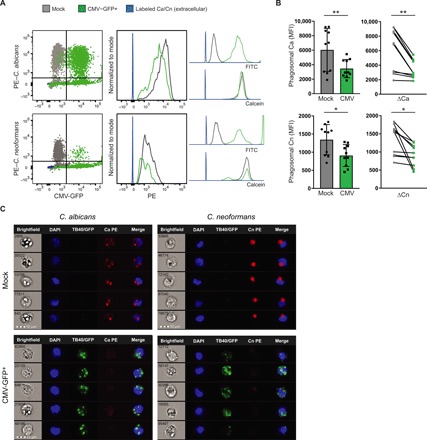
CMV-infected monocytes have a decreased phagocytic index for C. albicans and C. neoformans.pHrodo-red–labeled C. albicans (Ca) and C. neoformans (Cn) were incubated with mock- and CMV-infected PBMC cultures at a ratio of 5:1 for 1 hour, and phagocytosis of these fungal pathogens by CD14+ monocytes was analyzed by conventional flow cytometry and ImageStream. (A) Phagocytosis of C. albicans and C. neoformans by mock- and CMV-infected monocytes shown as overlay dot plots gated on calcein+ monocytes (left). Overlay histogram plots (middle) of the MFI of phycoerythrin (PE), the marker for phagosomal C. albicans and C. neoformans, from one representative experiment are shown. Intracellular, intraphagosomal C. albicans or C. neoformans was distinguished from extracellular, red-labeled fungi (blue) as pHrodo-red intensifies in fluorescence only when subject to an acidification in the phagosome. Layered histogram plots (right) show distinct separation of mock- and CMV-infected GFP+ monocytes by FITC but overlapping calcein plots. Results from a representative experiment are shown. (B) Whisker plots and before-and-after diagram of composite data from all biological and technical replicates from pHrodo phagocytosis assays (n = 10, C. albicans P = 0.002, C. neoformans P = 0.01, paired t test). (C) ImageStream analysis to visualize the phagocytic index of CMV-infected monocytes for C. albicans and C. neoformans. A panel of five representative mock- and CMV-infected monocytes subjected to a secondary challenge with pHrodo-labeled fungi confirms decreased phagocytic index of CMV-infected monocytes for both C. albicans and C. neoformans. Magnification, ×40. Scale bars, 10 μm. *P < 0.05 and **P < 0.01.